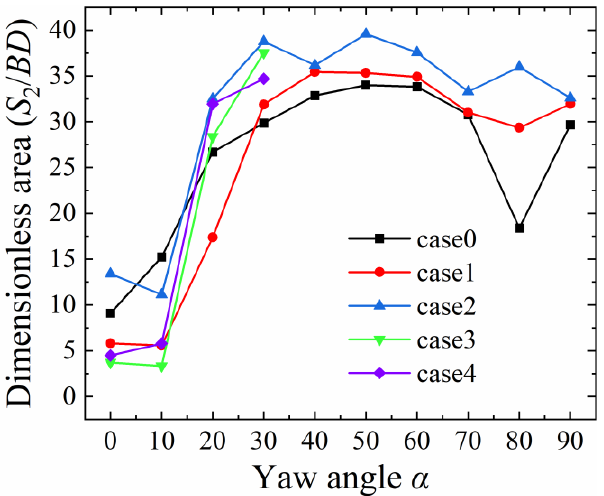
Figure 10. Area of PSD > 0.5 dominant frequency distribution region.